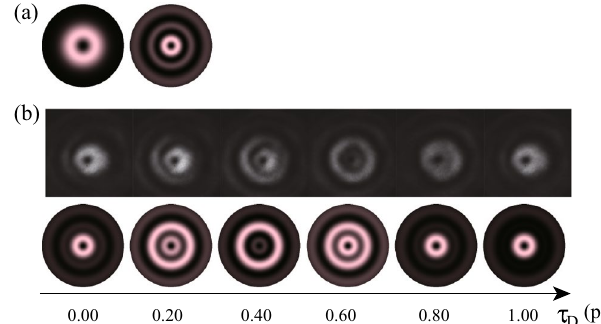
Figure 5. Ultrafast beam pattern modulation by the superposition of two chirped ℓ ( 0, 2 ) . ( a ) Constituent OV beam patterns of p 1 radial indices of ( p 1 , p 2 ) = time-divided spatial patterns of SFG recorded on the CMOS camera at the nominal time delay τ D between the generated pulse and the reference pulse of 0.00, 0.20, 0.40. 0.60, 0.80 and 1.00 ps. Experimental and simulated results are respectively at the top and bottom in ( b ).